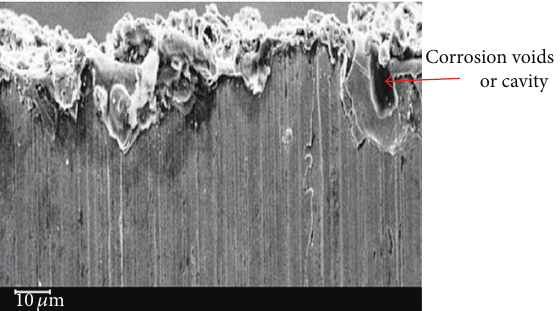
Figure 8: Crack tip voids formation and coalescence in a ductile fracture process of collecting plate.